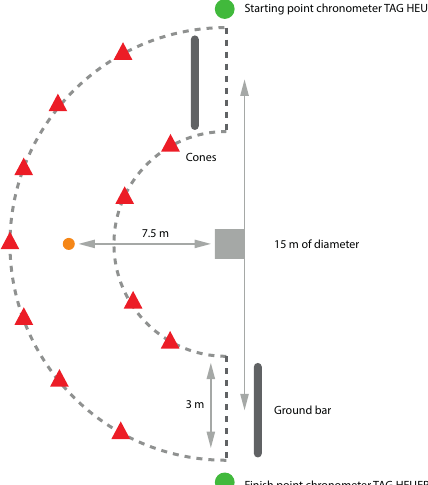
Figure 3. Plan of speed measurement on a curved path for a horse at left hand